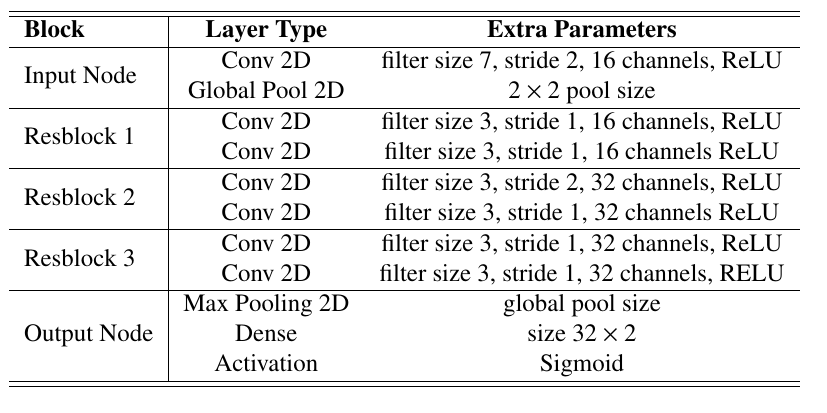
Table 2. Model architecture used in this study. All convolutional layers used same